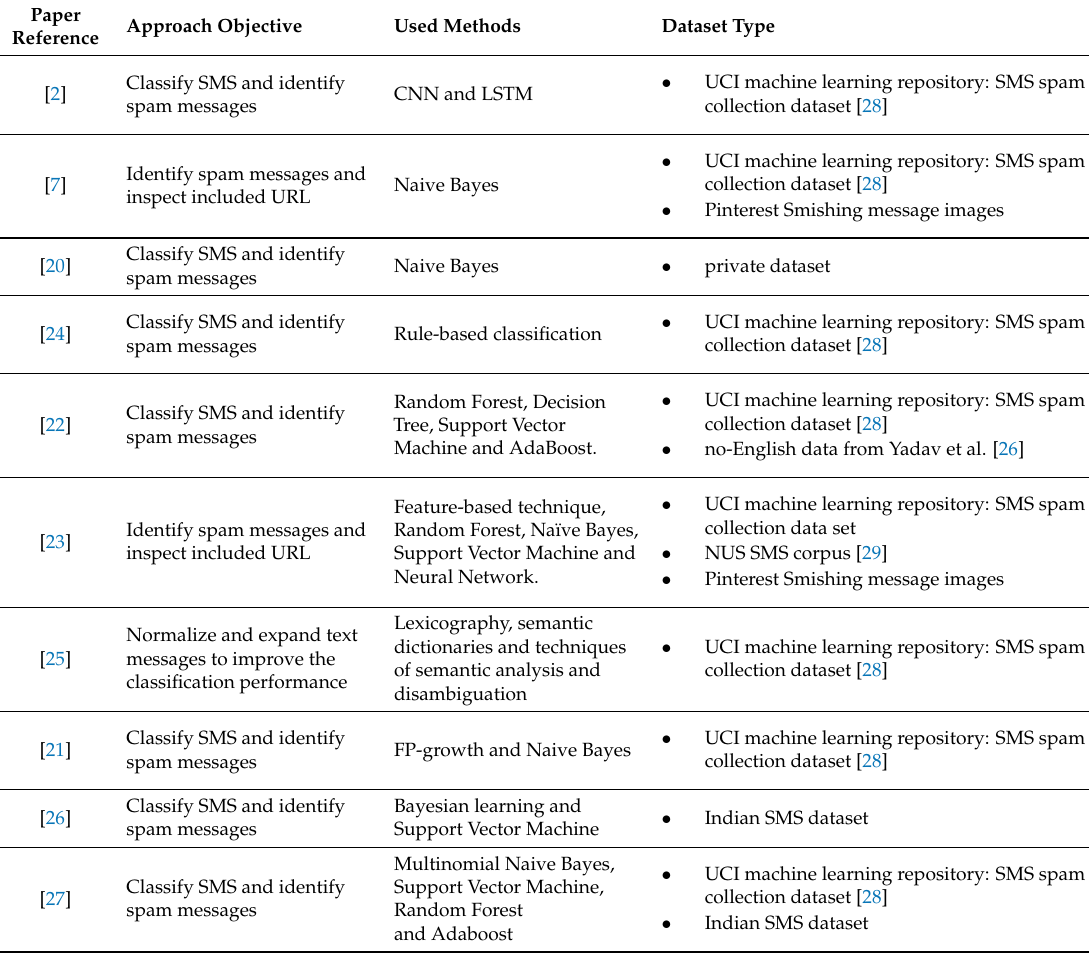
Table 1. Comparative Summary of related